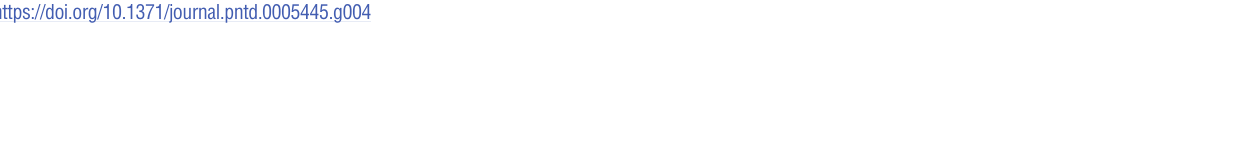
PLOS NeglectedTropical Diseases | https://doi.org/10.1371/journal.pntd.0005445 March 8,